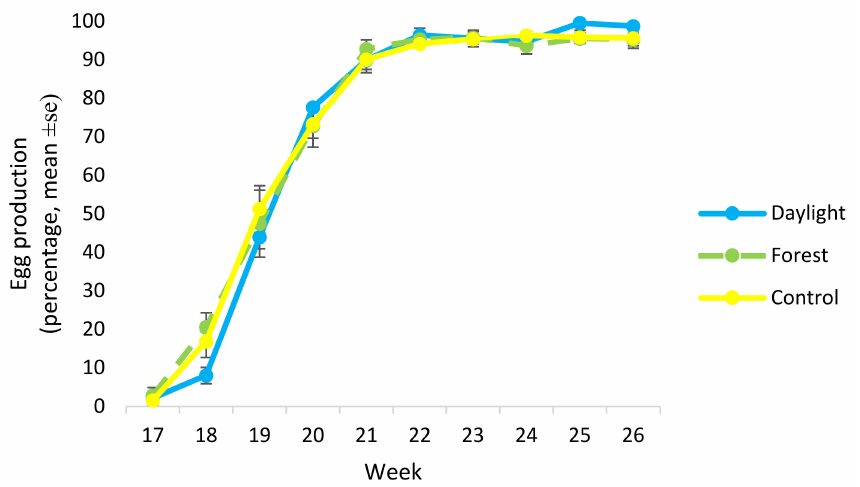
Figure 6. Percentage of eggs produced per week from start of lay until 26 weeks of age by birds from the different light